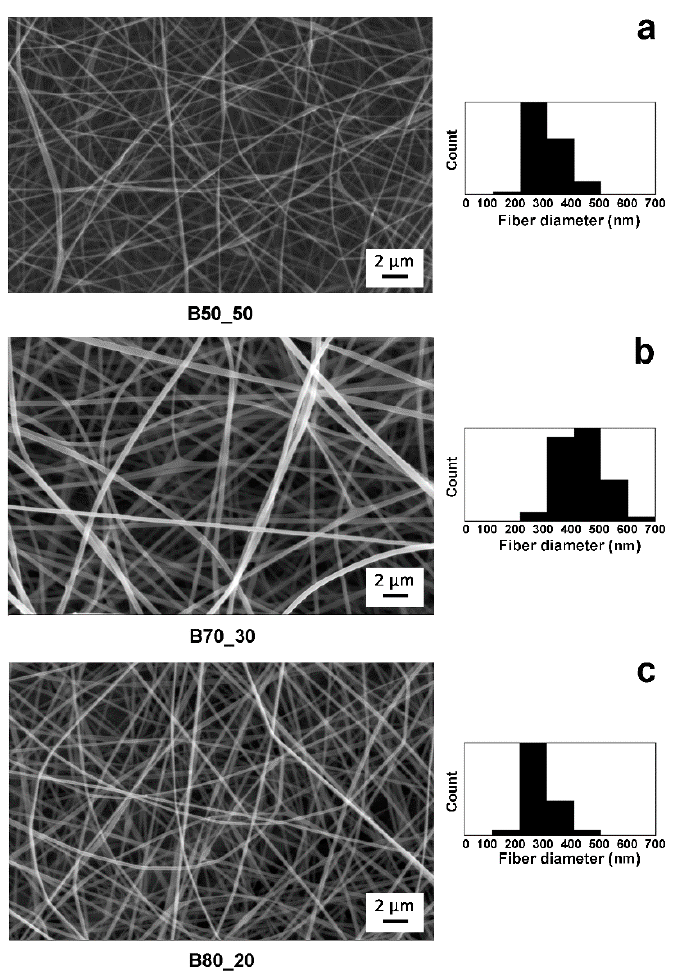
Figure 1. SEM micrographs of as-spun mats and histograms showing the fiber diameter distribution: B50_50 ( a ), B70_30 ( b ), and B80_20 ( c ).